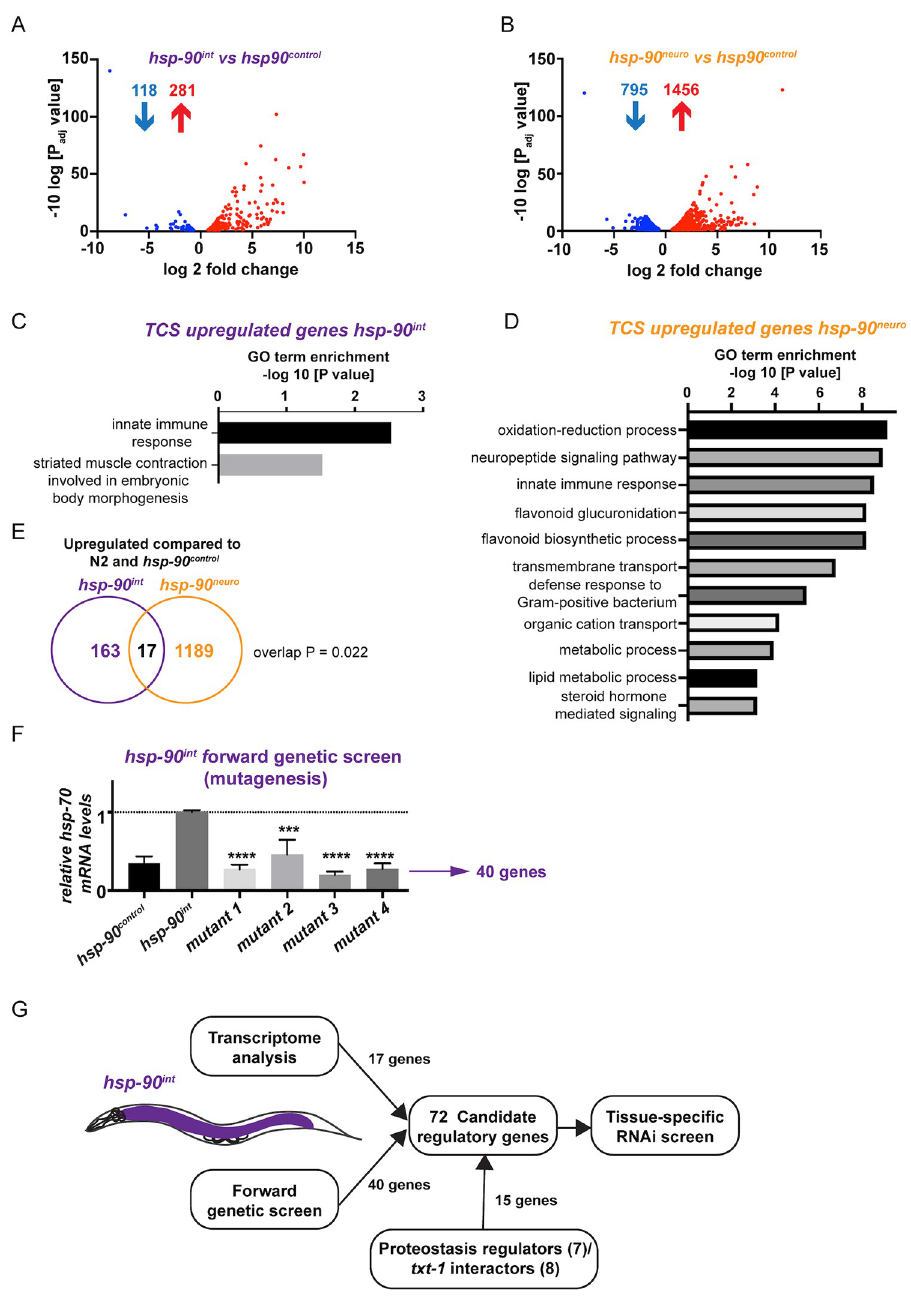
Fig 3. Transcriptional profiling (RNA-Seq) and a forward genetic mutagenesis screen identify candidate genes required for TCS. ( A ) RNA-Seq scatterplot showing log 2-fold change in expression levels of genes ( P < 0.05) differentially regulated (118 down-regulated; 281 up-regulated) in the TCS-activated strain hsp-90 int compared to hsp- 90 control . ( B ) RNA-Seq scatterplot showing log 2-fold change in expression levels of genes ( P < 0.05) differentially regulated (795 down-regulated; 1,456 up-regulated) in the TCS-activated strain hsp-90 neuro compared to hsp-90 control . ( C ) GO enrichment analysis of genes up-regulated by TCS in hsp-90 int . GO categories are reported as the -log 10 transformation of the P value. ( D ) GO enrichment analysis of genes up-regulated by TCS in hsp-90 neuro . ( E ) Venn diagram analysis of genes up-regulated in both hsp-90 int and hsp-90 neu . P value overlap = 0.022 was calculated using probability mass function of overlap size based on hypergeometric distribution. ( F ) hsp-90 int mutants isolated after an EMS mutagenesis screen showing reduced global hsp-70 mRNA expression that are comparable to hsp-90 control control animals. WGS analysis identified 40 mutated genes in the isolated hsp-90 int mutants. See also S2 Fig. Bar graphs represent the average of 3 biological replicates of > 50 animals per strain; error bars represent SEM of the 3 biological replicates. Significance compared to the original strain hsp-90 int (pre-mutagenesis) was determined using Student’s t test. ��� P < 0.001; ���� P < 0.0001. ( G ) Flowchart of identification of the 72 candidate genes resulting from